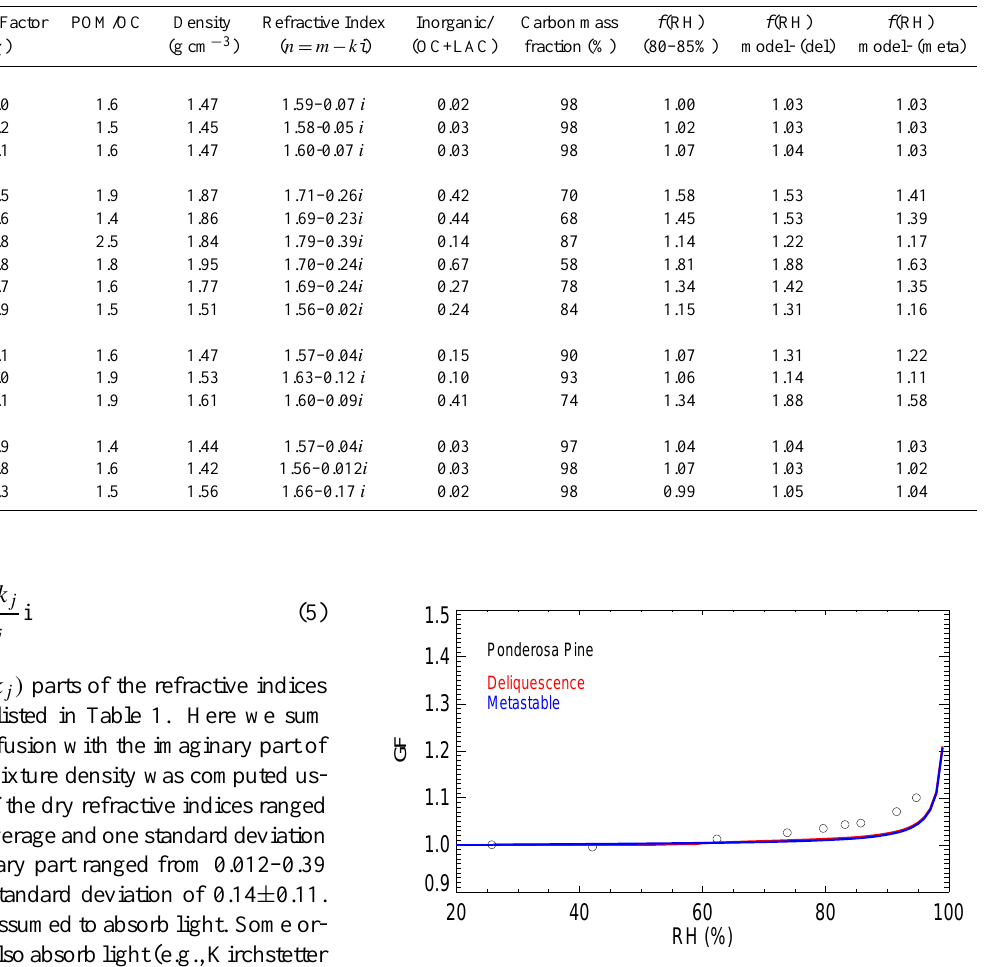
Fig. 2. Growth factors (GF) for 100nm smoke particles emitted from ponderosa pine burns as a function of relative humidity (RH, Figure 2. Growth factors ( GF ) for 100 nm smoke particles emitted from ponderosa pine %). The GF results derived from the E-AIM model are for deliques- burns as a function of relative humidity (RH, %). The GF results derived from the E-AIM cence and metastable model are for deliquescence and metastable equilibrium.